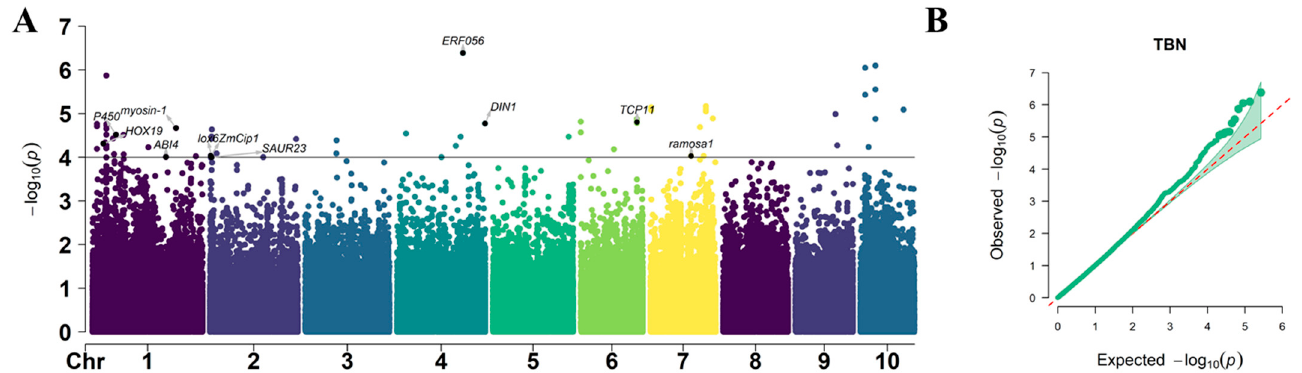
Figure 8. Manhattan plots of GWAS results showing the significant SNPs associated with TBN traits. ( A ) Manhattan plot. Each dot represents a SNP. The black solid line represents the threshold of 1× 10 –4 . ( B ) Quantile–Quantile (Q–Q) plots. The red line is the trend line to which the ideal Q–Q plot in each case should correspond.